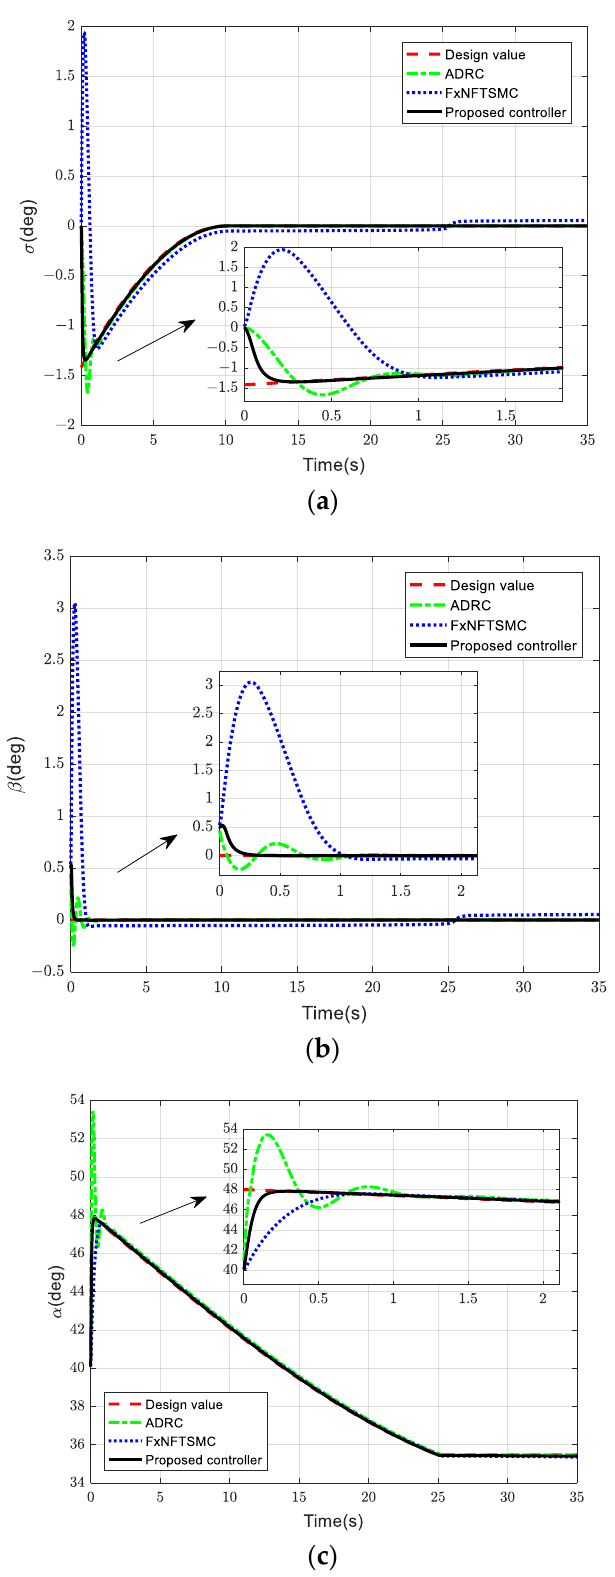
Figure 5. Attitude tracking curves of σ , β , α : ( a ) the roll channel; ( b ) the yaw channel; ( c ) the pitch channel.